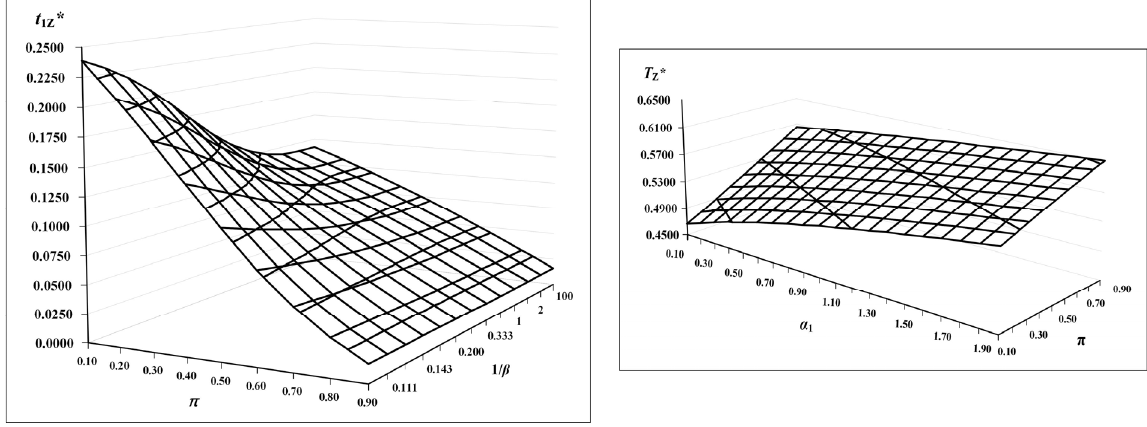
Fig. 11. Collective effect of differences in 1/ β and π on t 1Z * Fig. 12. Combined effect of changes in α 1 and π on t 1Z